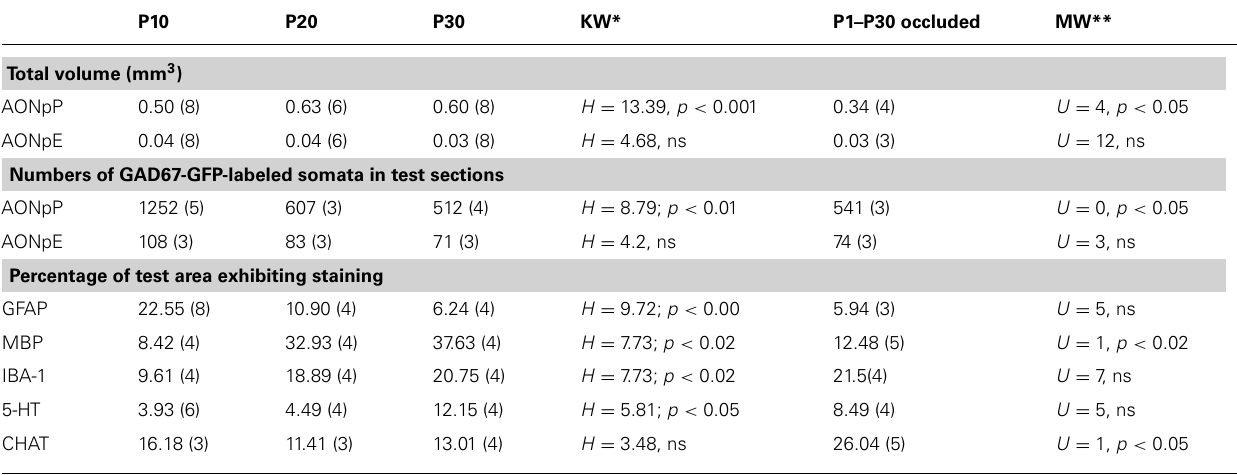
Table 2 | Statistical